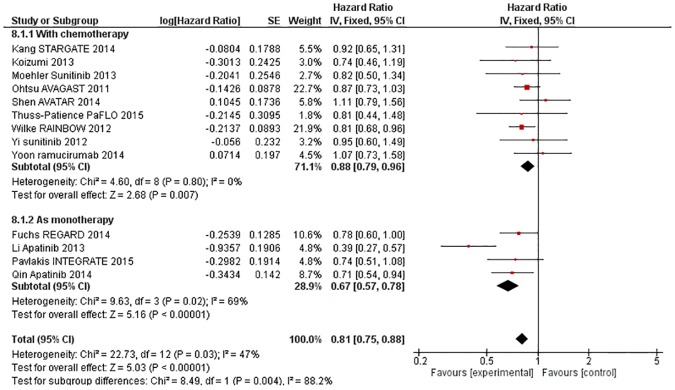
Forest plot—Overall Survival—with chemotherapy vs as monotherapy.